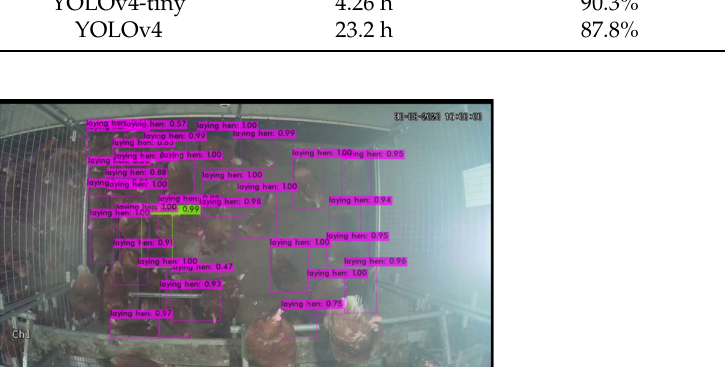
tiny. Purple boxes identify images as laying hen with the corresponding confidence interval. Green